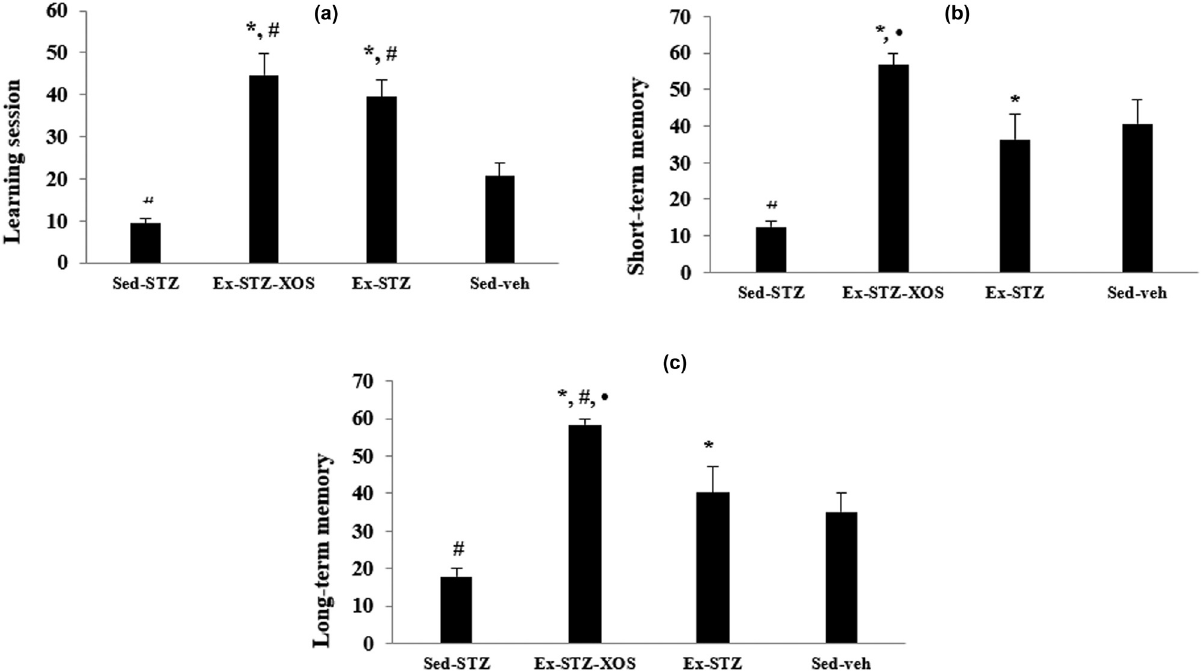
Figure 3: E ff ect of XOS and/or the aerobic training on the results from the passive - avoidance step - down test. ( a ) Learning session; ( b ) Short - term memory; ( c ) Long - term memory. * Signi fi cant di ff erences in comparison to Sed - STZ; # signi fi cant di ff erences in comparison to Sed - veh; and (cid:129) signi fi cant di ff erences in comparison to Ex -